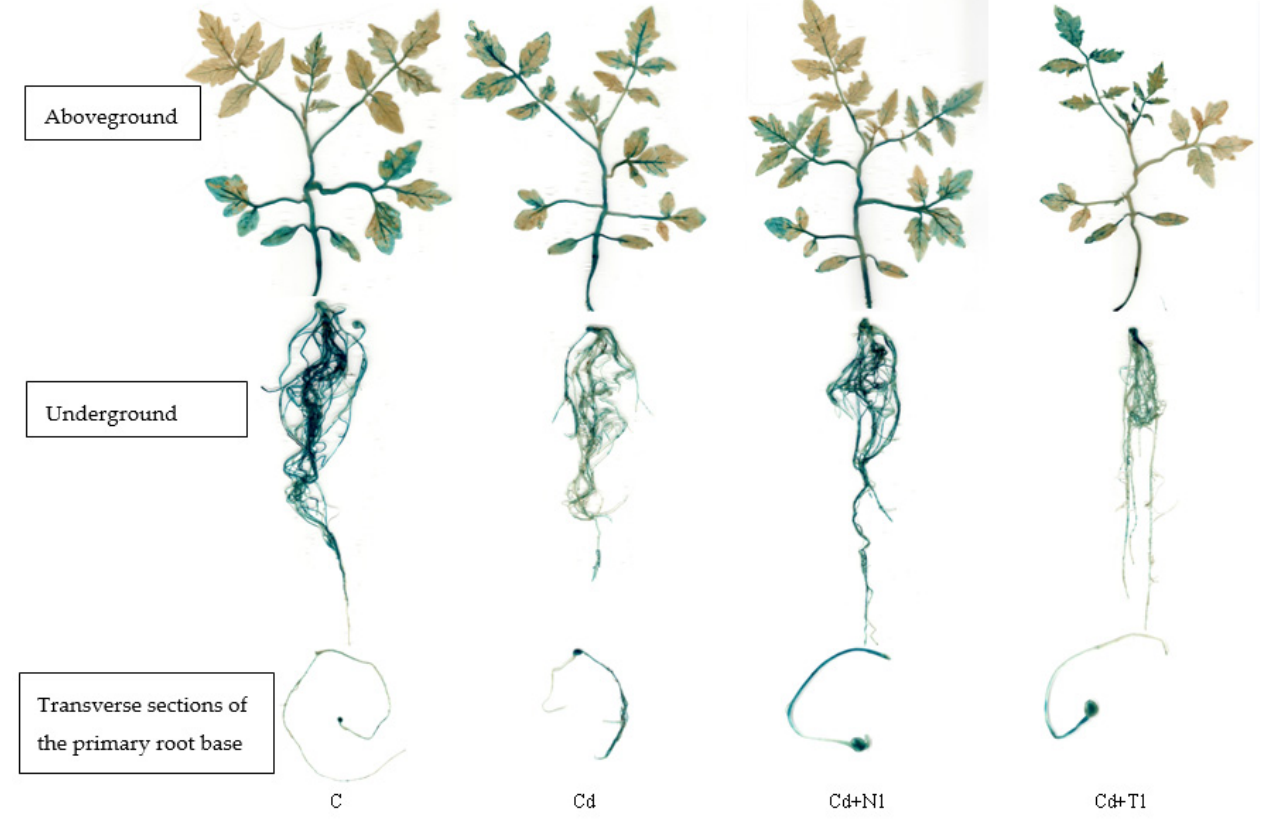
Figure 1. Distribution of auxin in tomato plants under Cd stress.C: 0 μ M Cd; Cd: 50 μ M Cd; Cd + N1: 50 μ M Cd + 0.5 μ M NAA; Cd + N2: 50 μ M Cd + 1 μ M NAA; Cd + T1: 50 μ M Cd + 100 μ M TIBA; Cd + T2: 50 μ M Cd + 200 μ M TIBA.